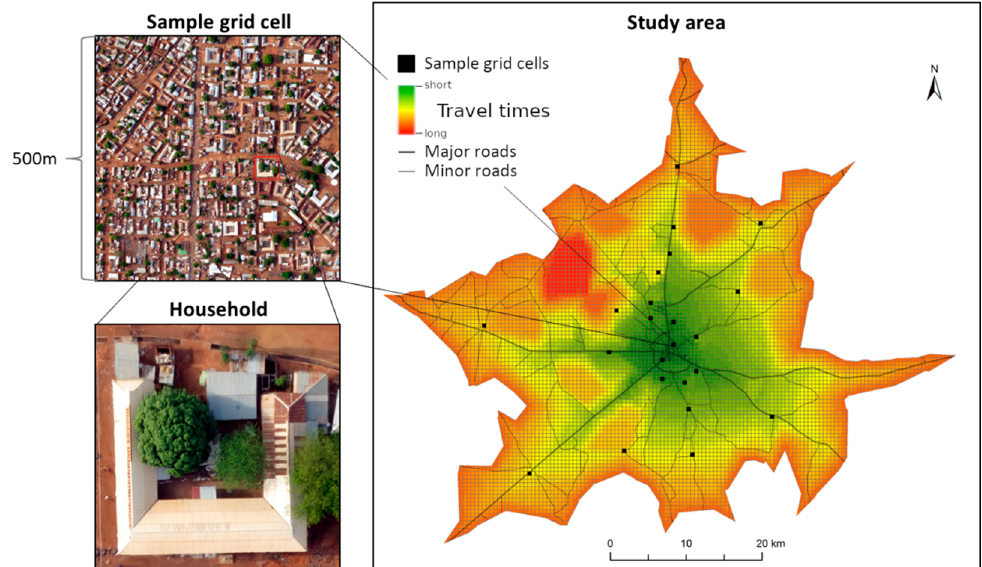
Figure 3. Multi-scale sampling scheme comprising households, sample grid cells and the entire study area.